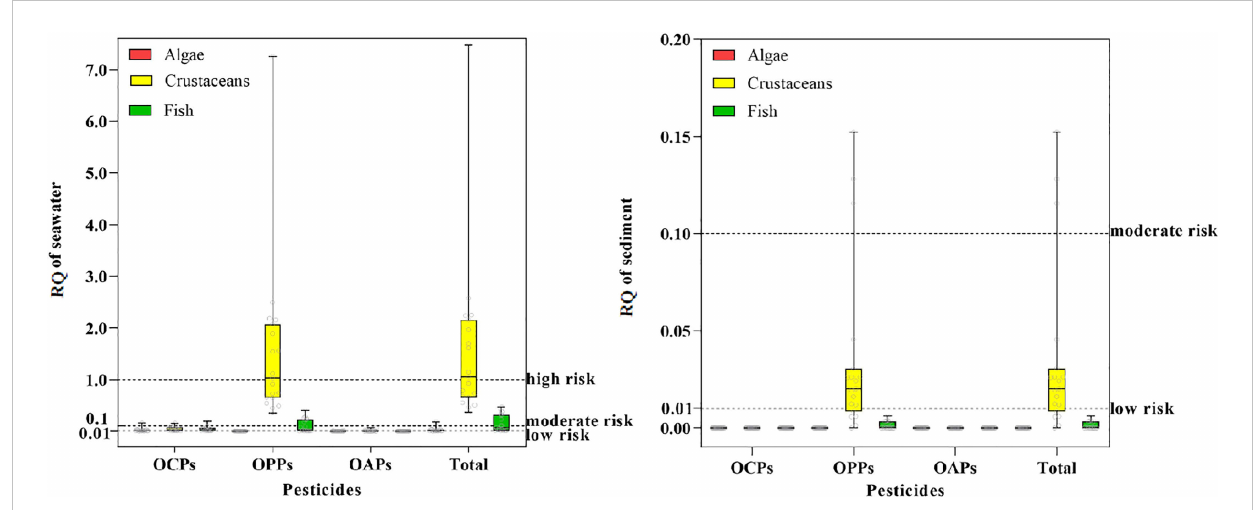
TABLE 3 The average daily dose of pesticides and health risks from the consumption of fi sh and shrimps.